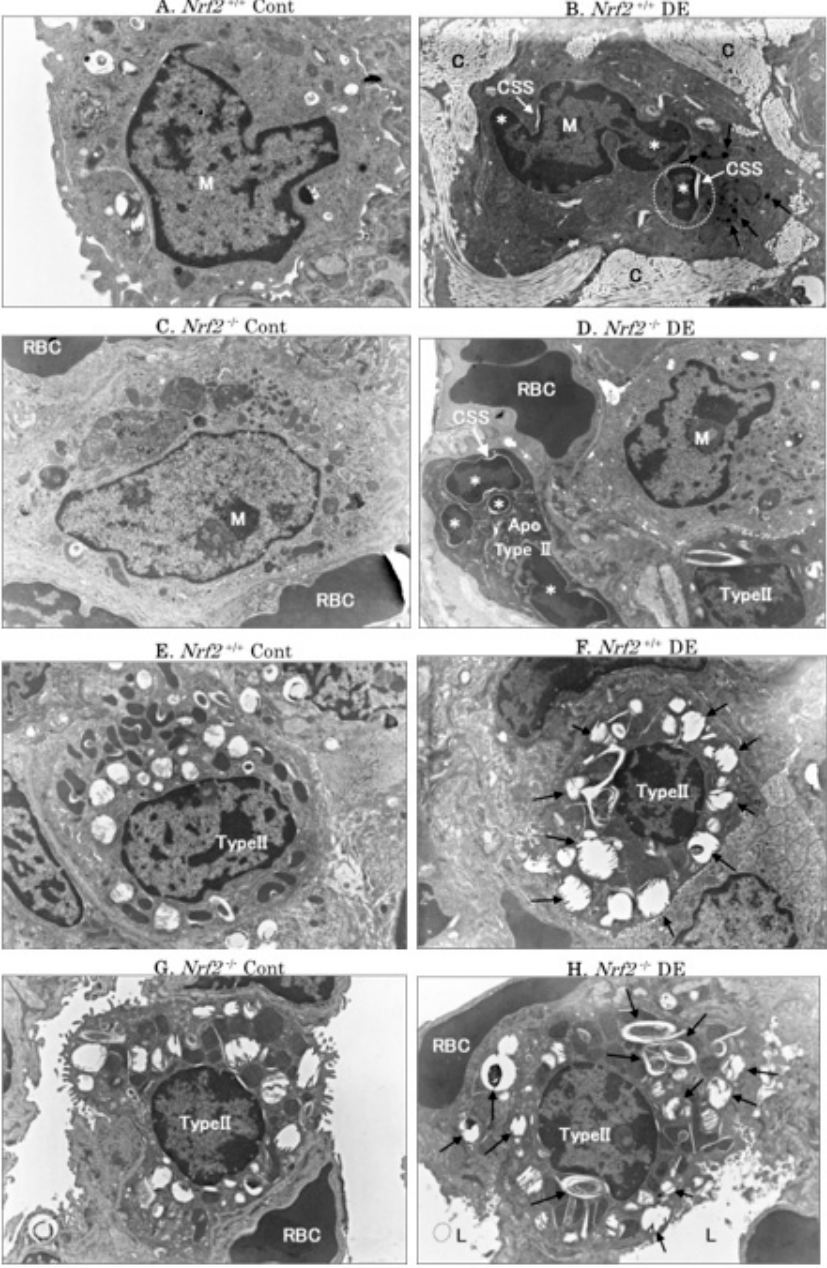
Figure 3. Electron microscopic analysis of alveolar macrophages and alveolar type II epithelial cells (Type II cells). The photographs show representative results. Alveolar macrophages in Nrf2 +/+ mice, control group ( A ), DE group ( B ); alveolar macrophages in Nrf2 − / − mice, control group ( C ), DE group ( D ). Type II cells in Nrf2 +/+ mice, control group ( E ), DE group (F); Type II cells in Nrf2 − / − mice, control group ( G ), DE group ( D , H ). Black arrows indicate alveolar macrophages engulfing DEP ( B ), and degeneration of the lamellar body ( F , H ). A white dotted ring indicates the apoptotic body that was phagocytosed by a macrophage ( B ). M: macrophage; Type II: alveolar type II epithelial cells; *: irregular condensed chromatin and nuclear fragmentation; CSS: crescent-shaped spaces (appearing around the nucleus of an apoptotic cell); Apo: apoptosis; RBC: red blood cell; C: collagen fiber; L: lumen.